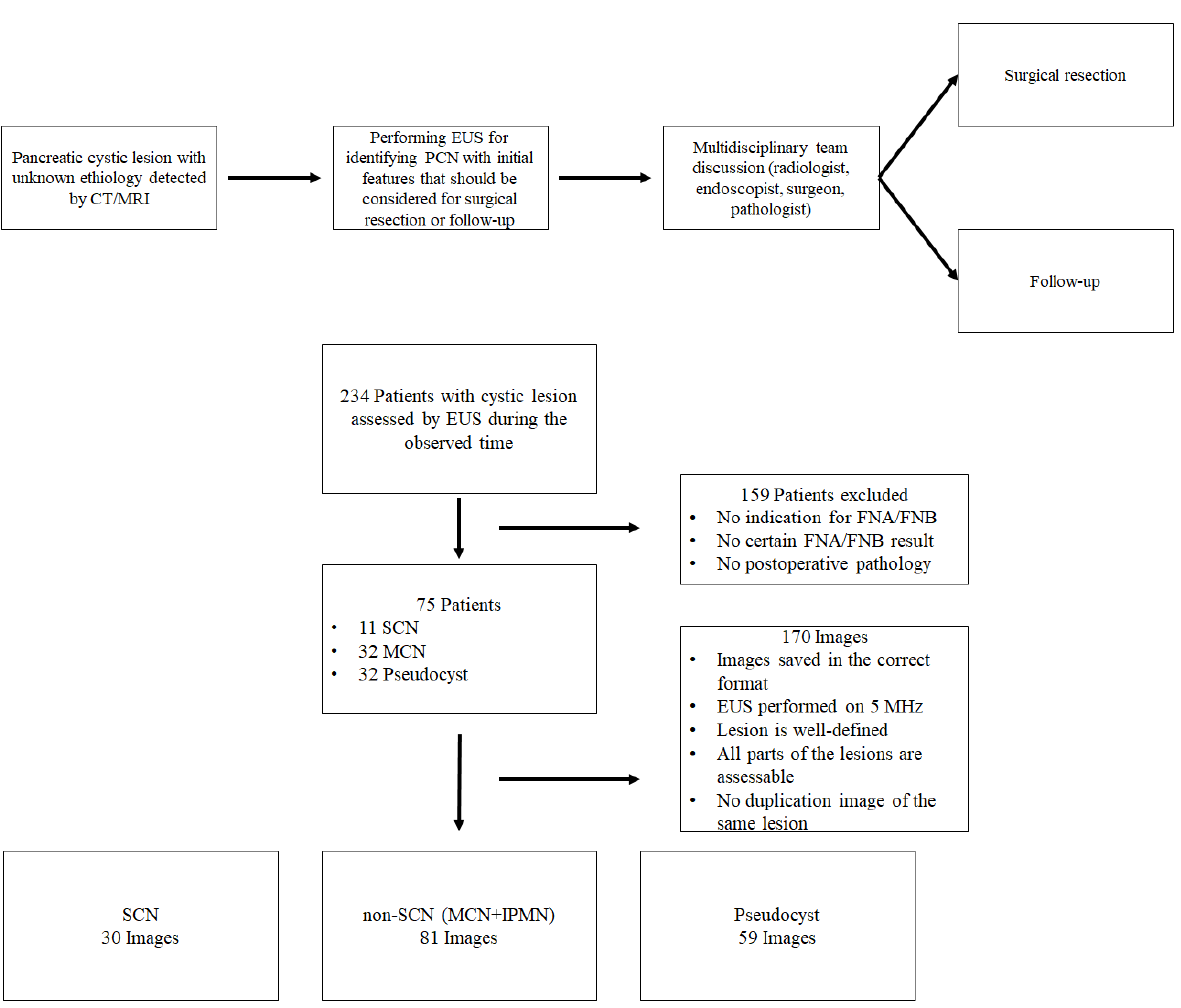
Figure 2. Inclusion and exclusion criteria of patients and evaluation method. Diagnostic flowchart. The mean age of the patients in the SCN, Non-SCN and the Pseudocyst groups were 59.4 ± 20.1, 61.8 ± 11.5 and 63.3 ± 13.1 years, respectively. In the SCN group 82% (9/11) of the patients were female, while in the Non-SCN and Pseudocyst groups 72% (23/32) and 63% (20/32), respectively. There were no significant differences between the groups in terms of age and gender (Table